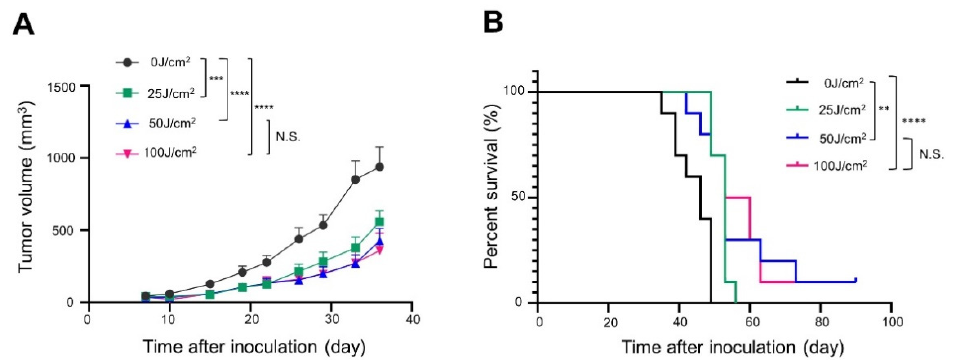
Figure 6. In vivo long-term efficacy of NIR-PIT with Cet-IR700 in mEERL-hEGFR tumors: ( A ) tumor volume curve ( n = 10; one-way ANOVA followed by Tukey’s test; ***, p < 0.001 and ****, p < 0.0001; ns: not significant); ( B ) Kaplan–Meier survival curve ( n = 10; log-rank test with Bonferroni correction; **, p < 0.01 and ****, p < 0.0001; N.S.: not significant).